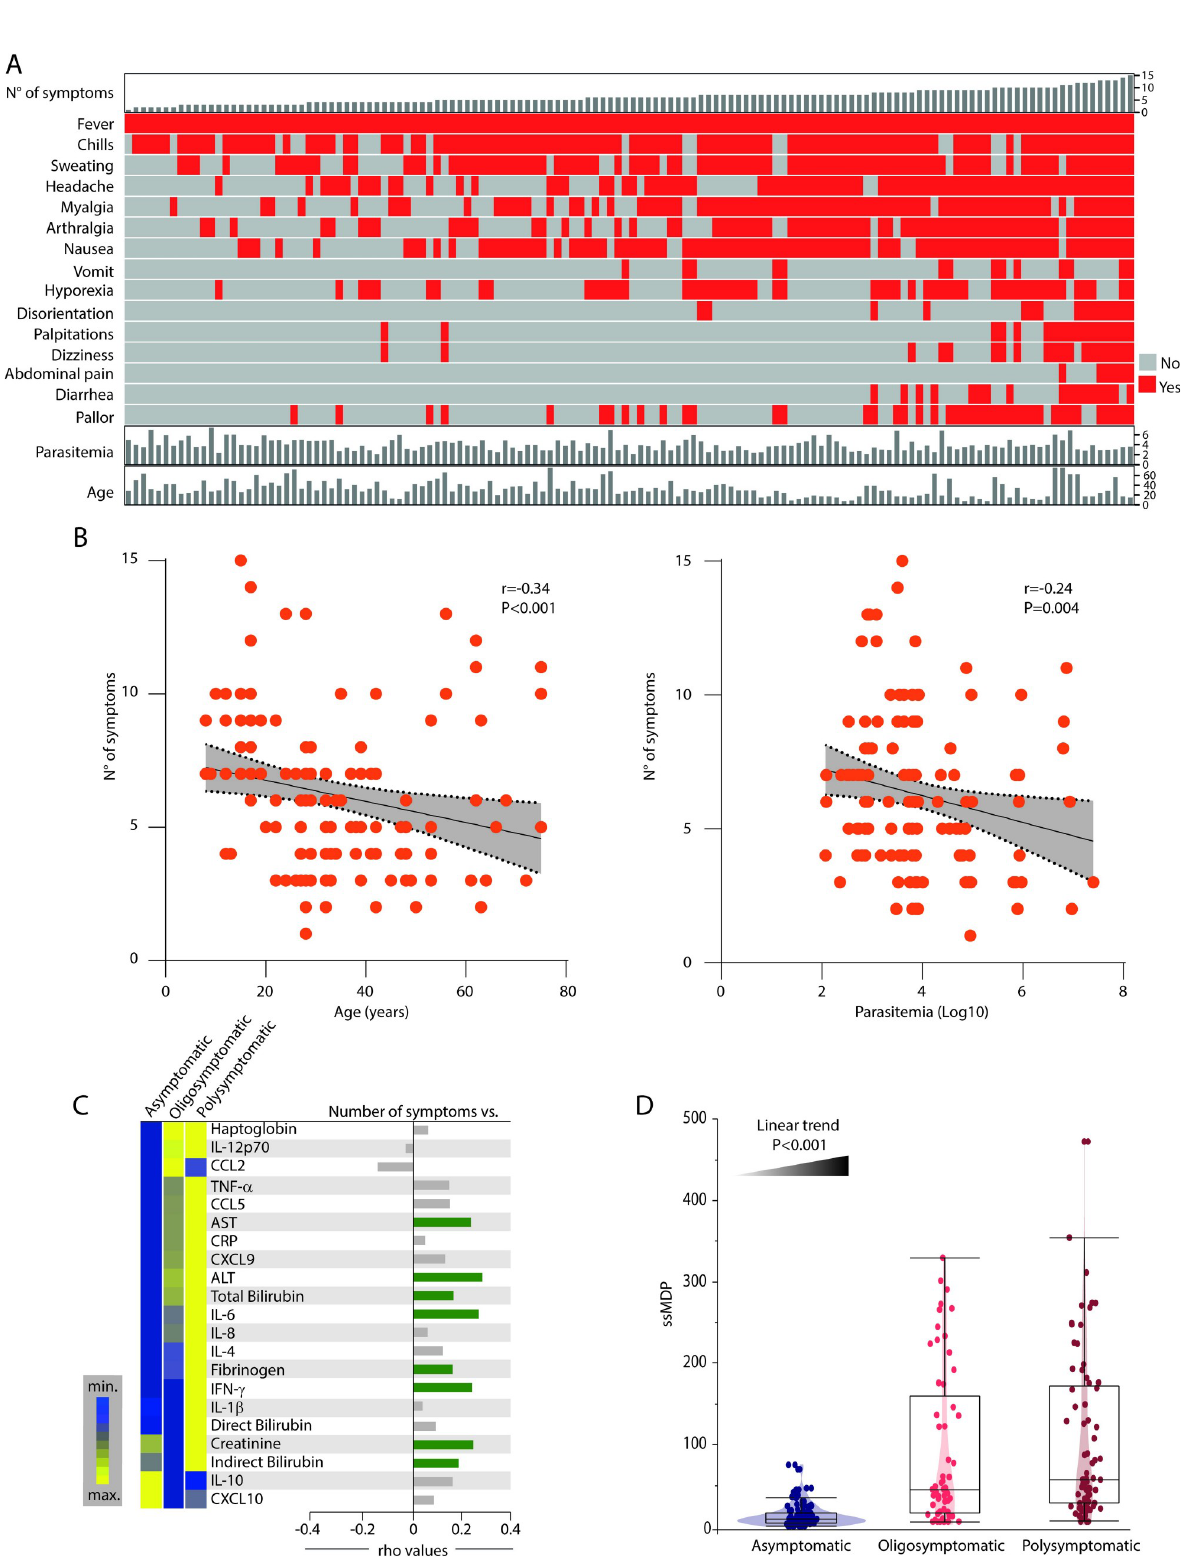
Fig 6. Impact of systemic inflammatory disturbance on the number of symptoms in Plasmodium vivax malaria. (A) Symptomatic P . vivax malaria patients were ordered according to the number of symptoms. A color map highlighting the detection of each symptom is shown. Parasitemia